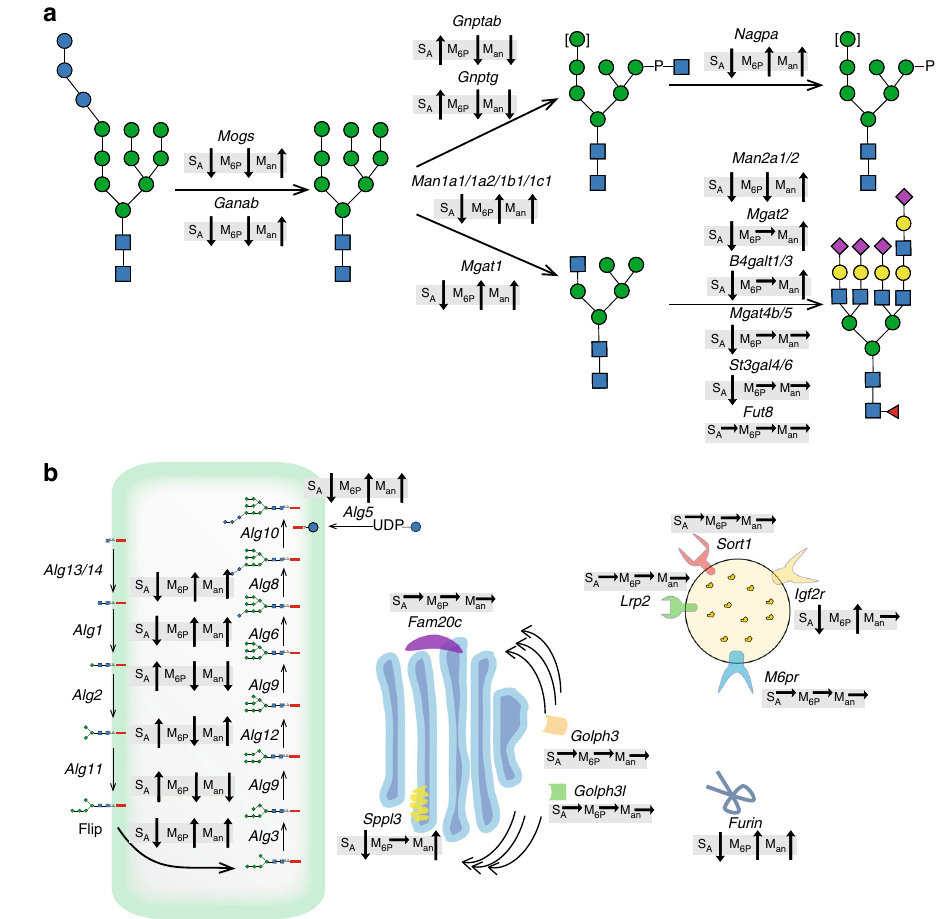
Fig. 1 Graphic depiction of gene targeting screen performed in CHO cells with general trend effects on N-glycosylation of α -galactosidase A (GLA). clustered regularly interspaced short palindromic repeats/CRISPR-associated protein 9 (CRISPR/Cas9) knockout (KO) targeted genes are indicated with their predicted functions. a The general trend effects of KO targeting of glycosyltransferase, glycosylhydrolase, and other related genes known to function in N-glycosylation and mannose 6-phosphate (M6P) tagging are indicated for changes in total sialic acid capping (SA), M6P-tagging (M6P), and exposed terminal mannose (Man), with arrows indicating increase/decrease. b Trend effects of KO targeting of genes encoding enzymes functioning in the dolichol-linked precursor oligosaccharide assembly, receptors involved in traf fi cking of lysosomal enzymes, and other proteins reported to affect stability of enzymes in the Golgi. Glycan symbols according to SNFG format